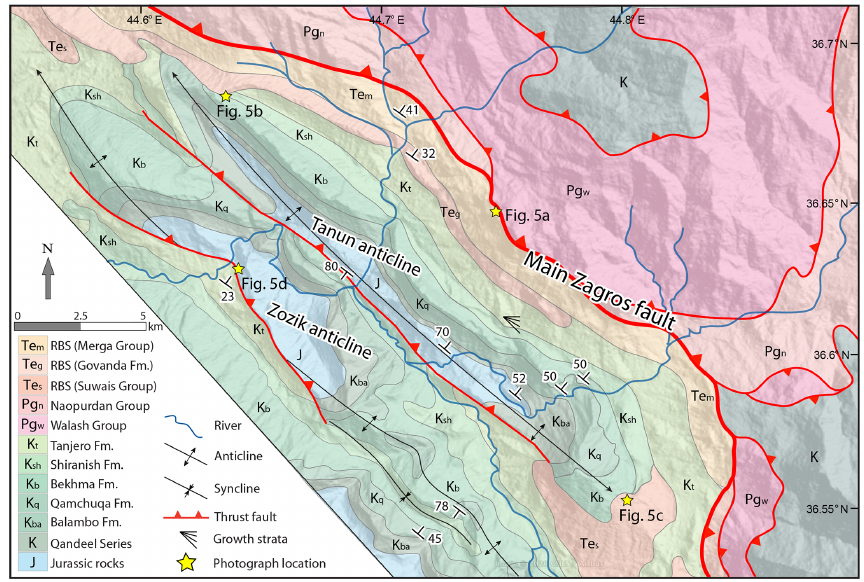
Figure 4. Geologic map illustrating key structural features, the growth strata location of the Tanjero Formation (Le Garzic et al., 2019), and the angular unconformity locations in the vicinity of the NW and SE plunges of the Tanun anticline. The base maps were sourced from Sissakian et al. (1997), MNR (2016), and Le Garzic et al.